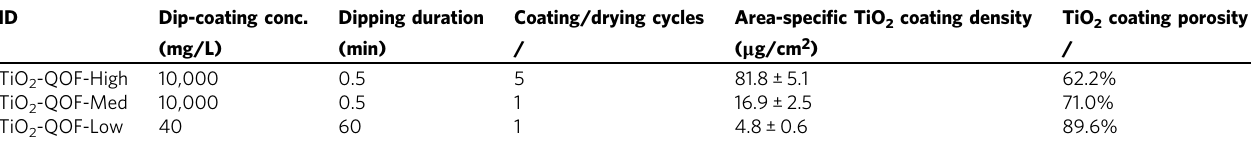
Table 1 Dip-coating conditions and TiO 2 coating layer parameters in the three TiO 2 -QOFs. ID Dip-coating